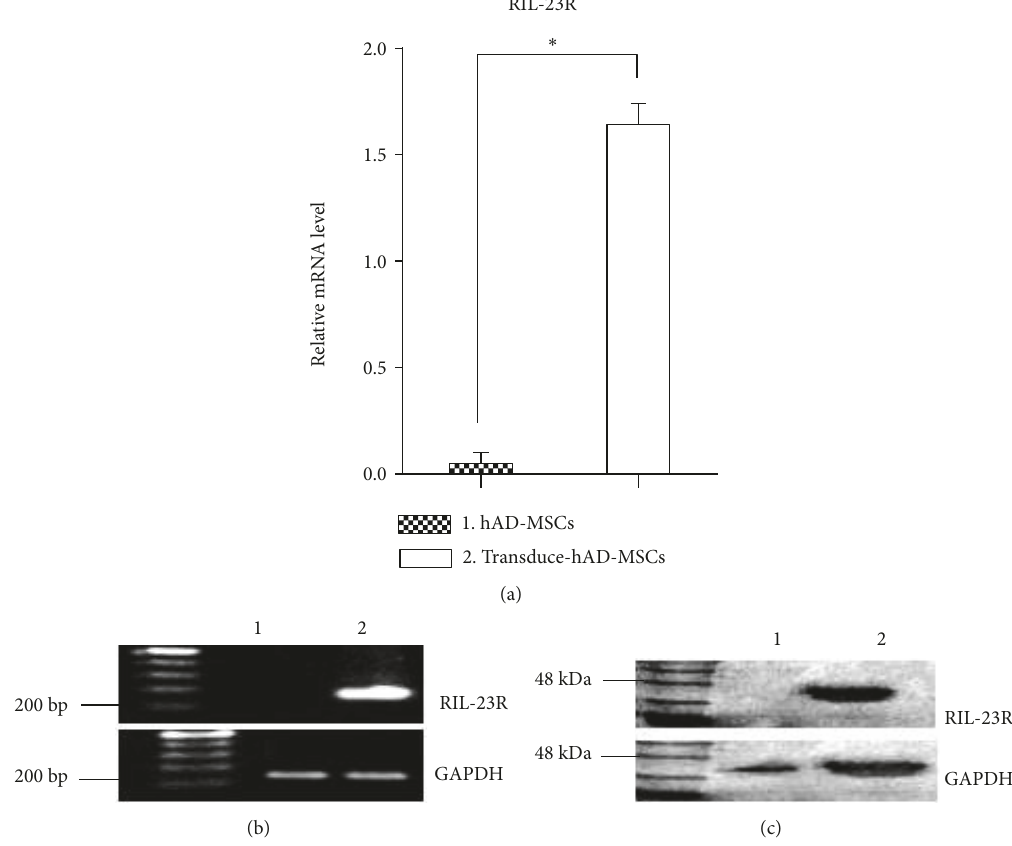
Figure 7: Expression of RIL- 23R in hAD-MSCs and transduced hAD-MSCs. (a-b) qPCR analysis of the RIL-23R in hAD-MSCs and transduced hAD-MSCs. the relative copy numbers of RIL-23R in transduced hAD-MSCs were compared with the copy number in hAD- MSC. The data are shown as means ± SD of 5 independent experiments. (c) Western blot analysis of the RIL-23R in whole cell lysates of hAD-MSCs (20 𝜇 g protein was loaded per